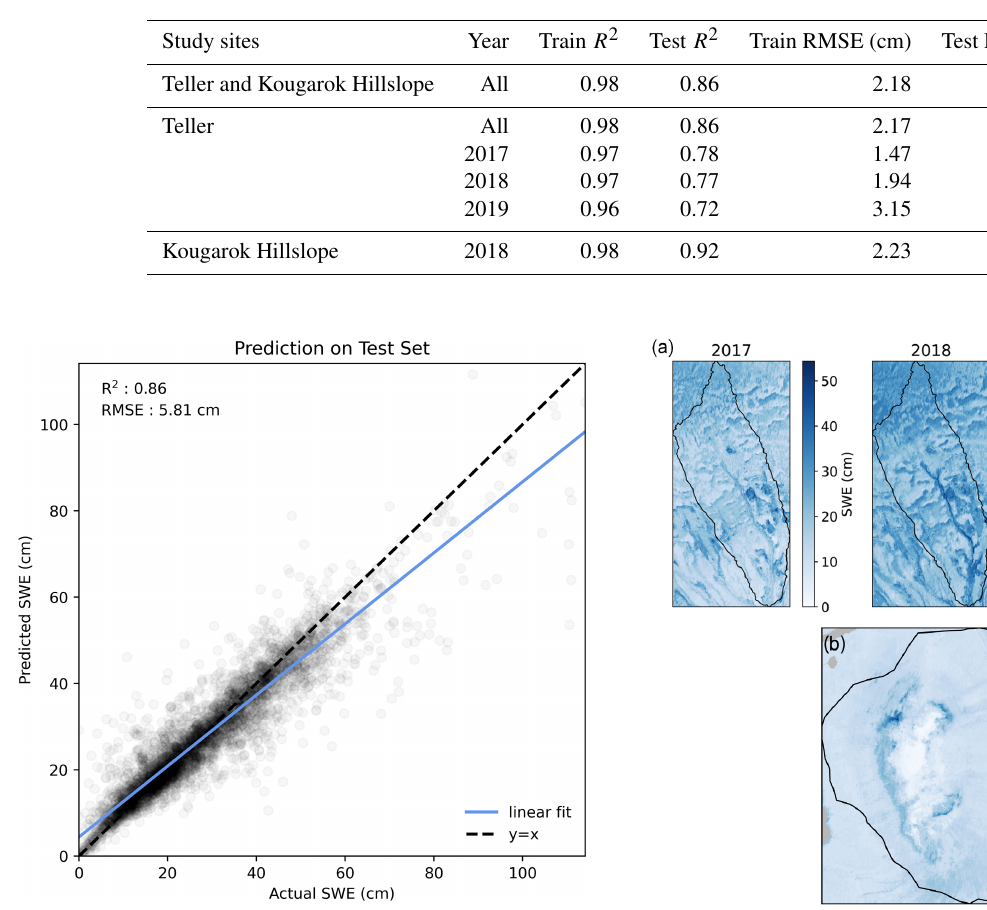
Table 4. Random forest results for the training and testing data used to estimate SWE.